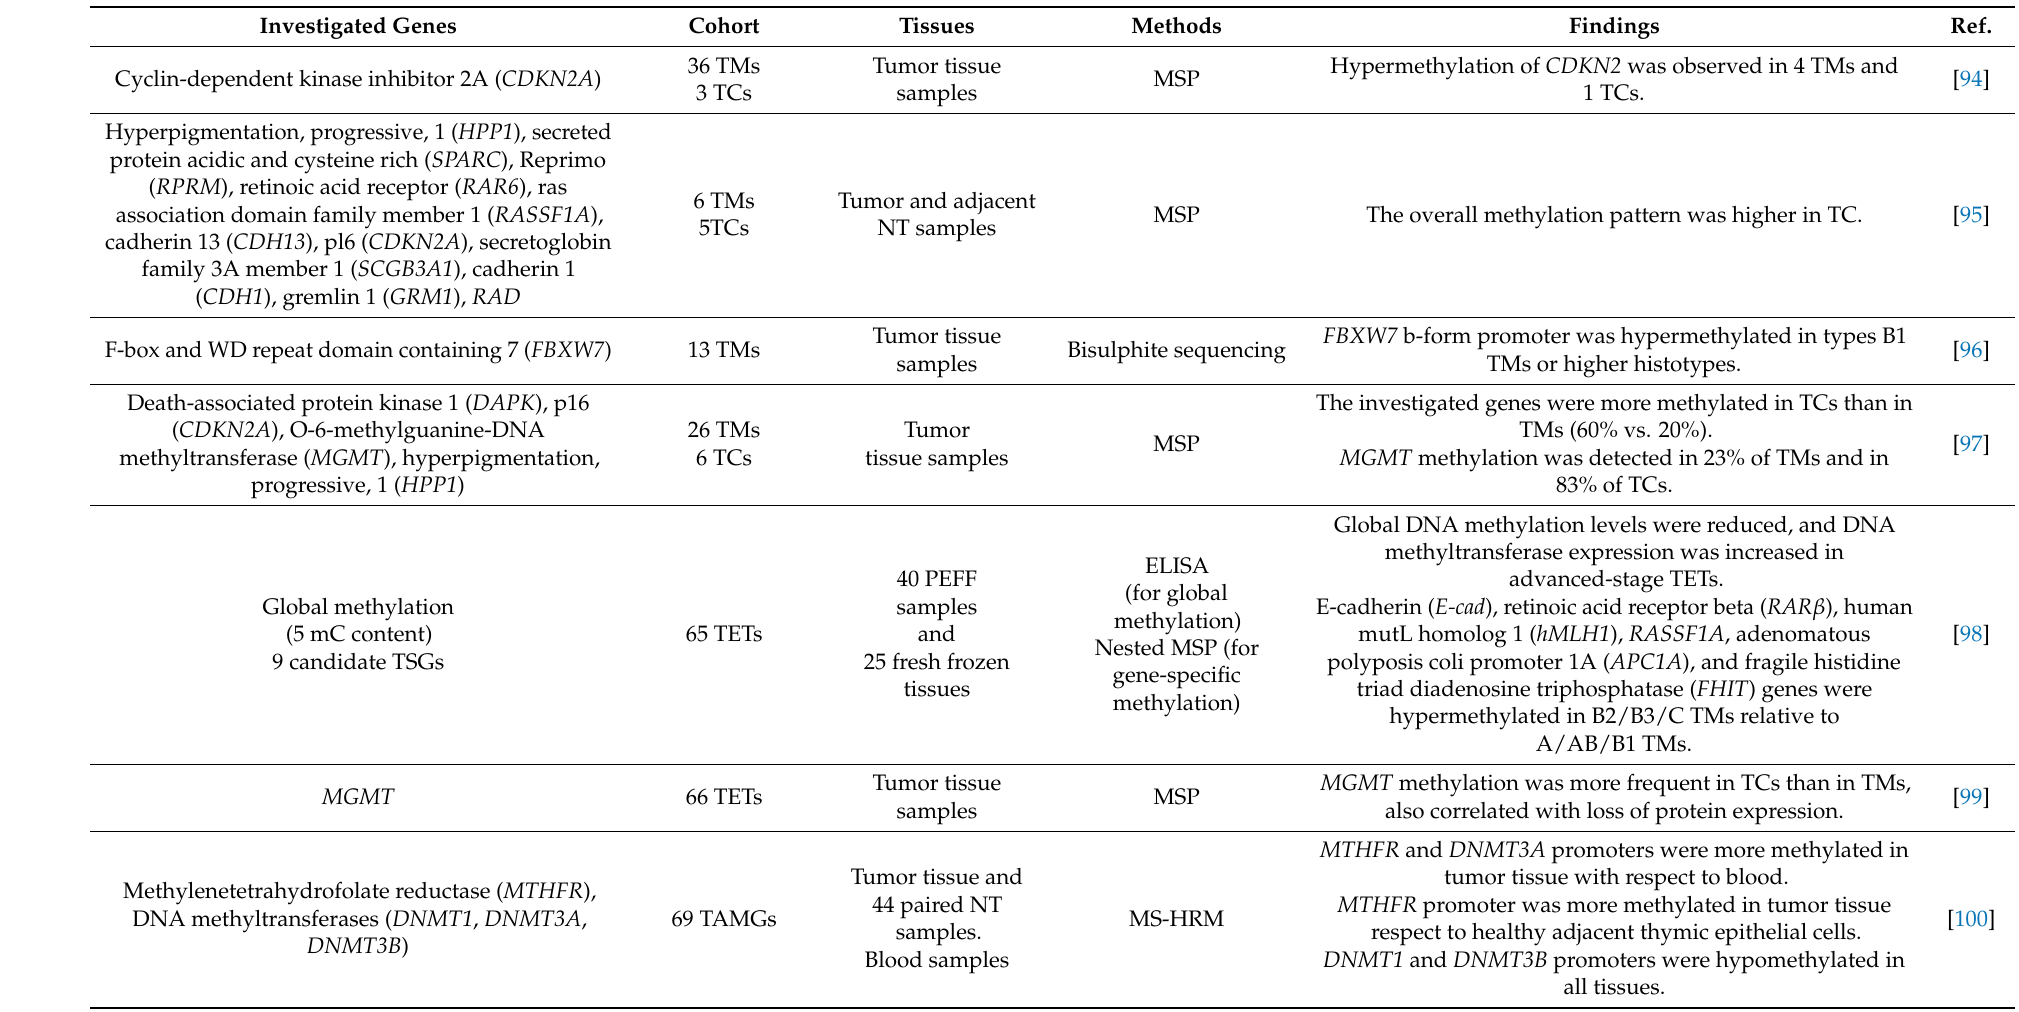
Table 1. Works investigating the methylation status of